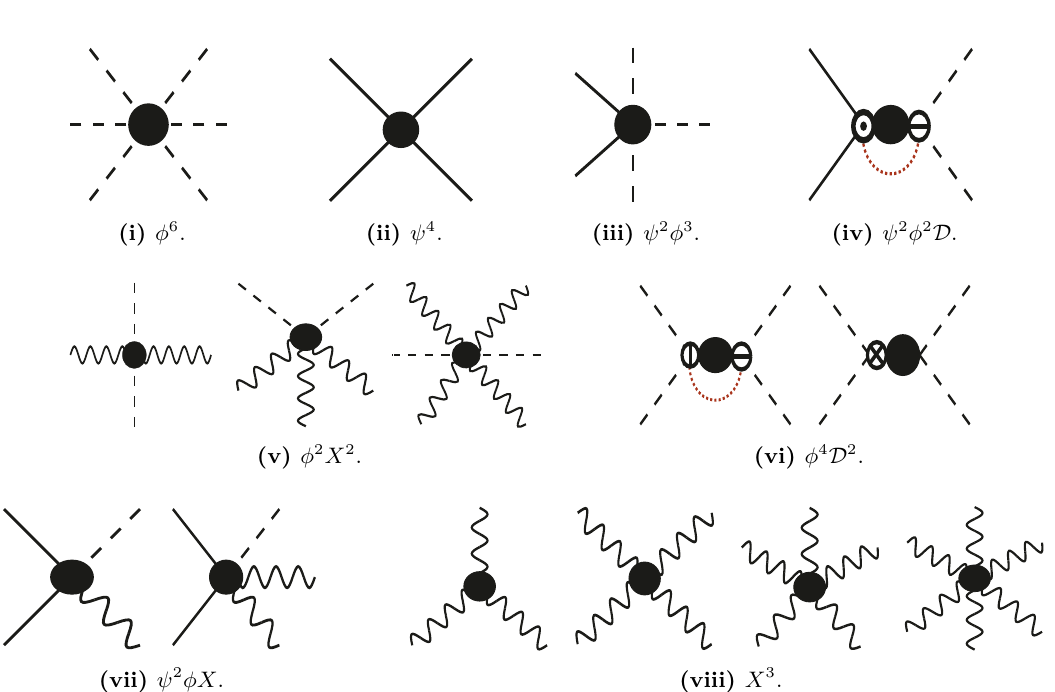
Figure 2 . Schematic representation of SMEFT operator classes at mass dimension-6 in the Warsaw basis. The dotted red line indicates the contraction of Lorentz indices as mentioned in table